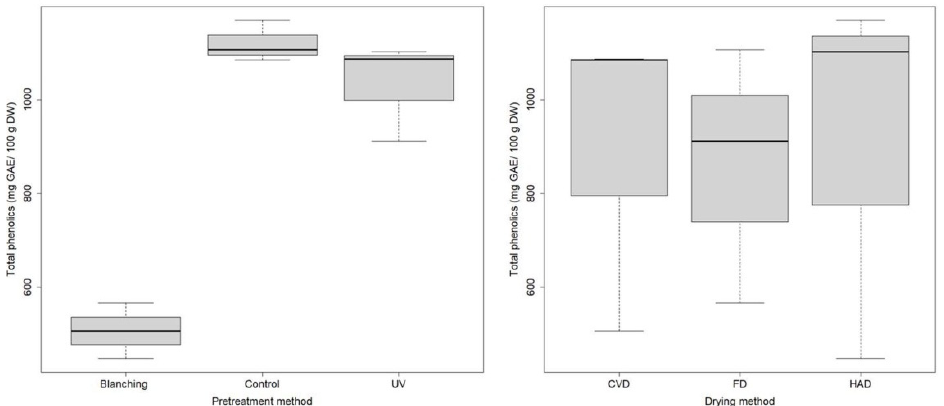
Figure 3. Boxplot of the TPC of B. edulis dried mushrooms in relation to pretreatment for all dried samples, and in relation to drying for all pretreated samples.